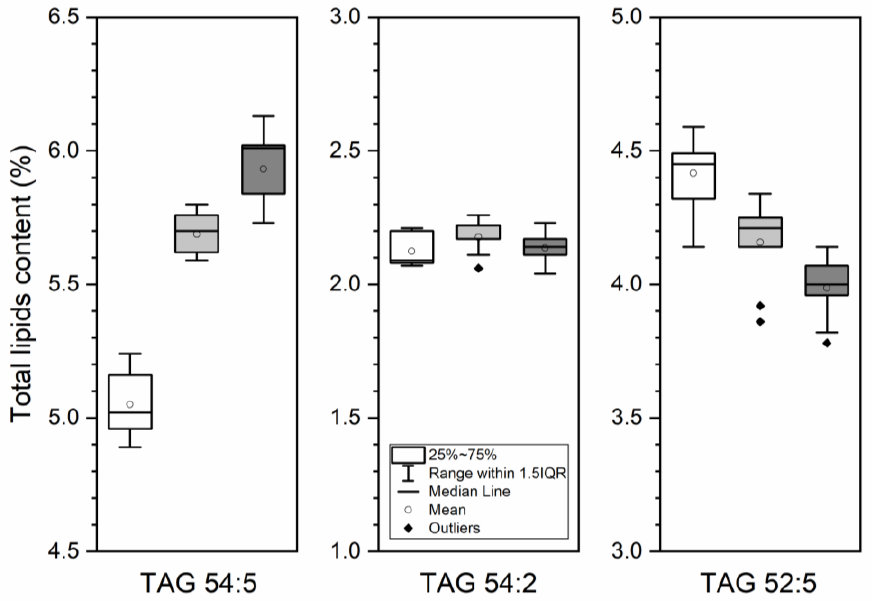
Figure 6. Representative changes observed in TAG 54:5 (18:1 / 18:2 / 18:2), 54:2 (16:0 / 18:1 / 20:1), and 52:5 (16:0 / 18:2 / 18:3) when comparing Arabidopsis control (WT, white) and octanoyltransferase mutants ( lip2p1 , grey, and lip2p2 , dark grey) mature seeds. Data are average values ± SD of three biological replicates with two technical ones.